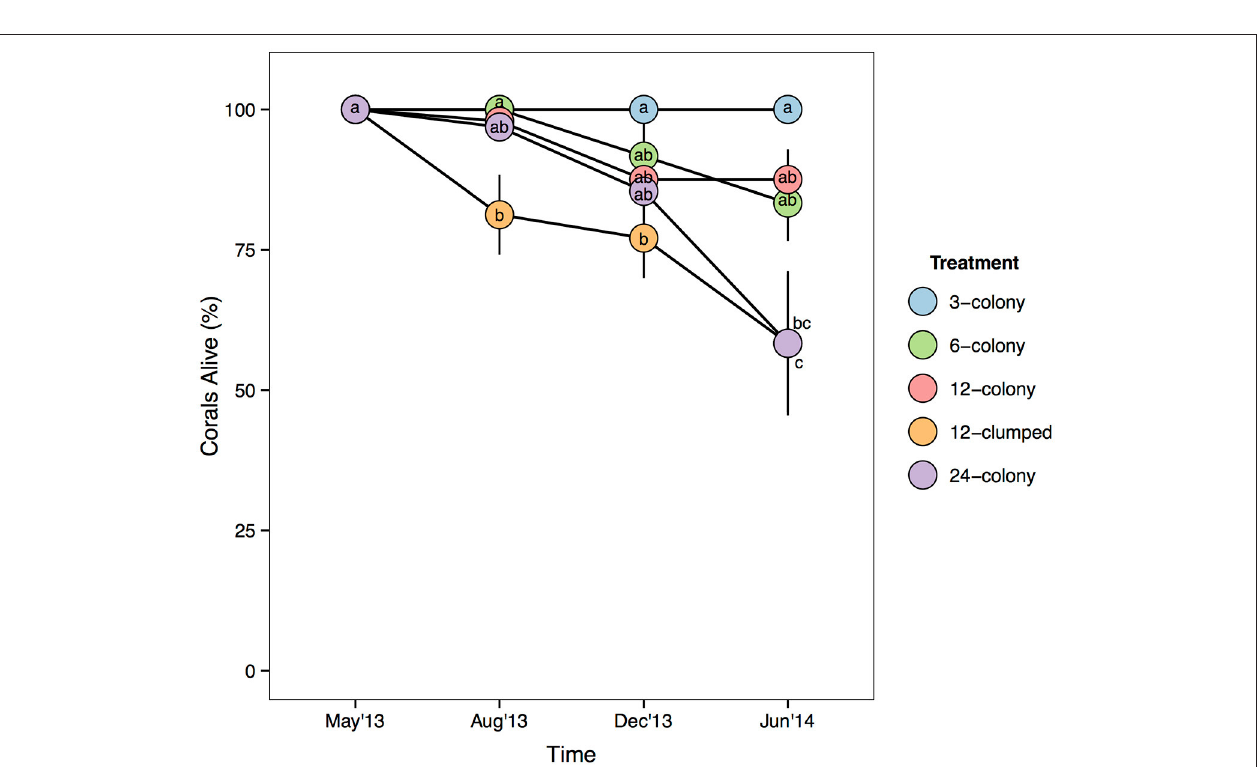
FIGURE 5 | Mean survivorship of coral colonies by treatment over time. Statistics are from nested two-way repeated measures ANOVA. Letters represent significant differences ( p < 0.05) among treatments within a time period from post-hoc tests with Tukey’s correction. Data are means ± SE.